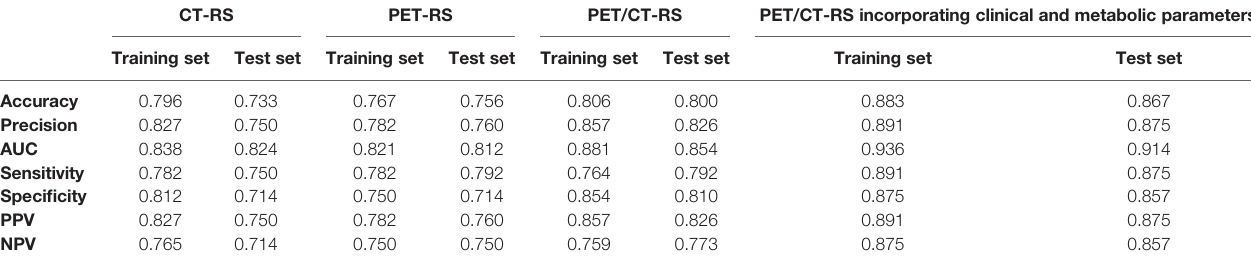
TABLE 2 | Diagnostic Performance of different radiomics models. CT-RS PET-RS PET/CT-RS PET/CT-RS incorporating clinical and metabolic parameters